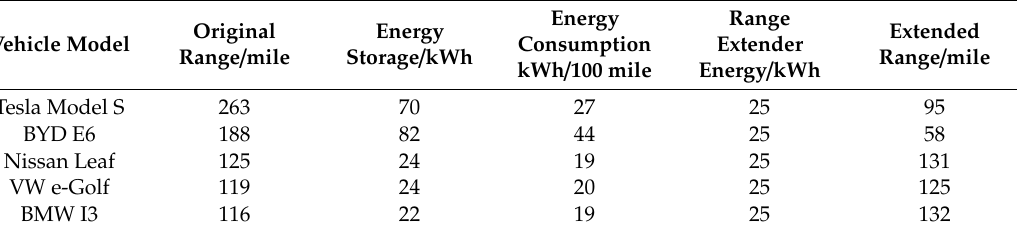
Table 8. Specifications of current BEVs [3].